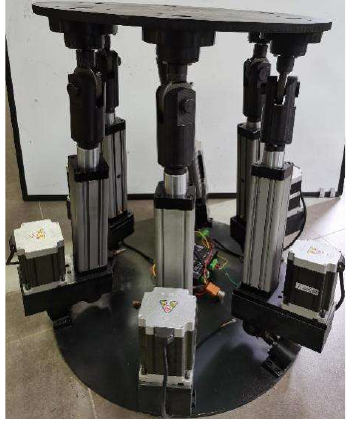
Figure 12. Physical drawing of lifting platform.